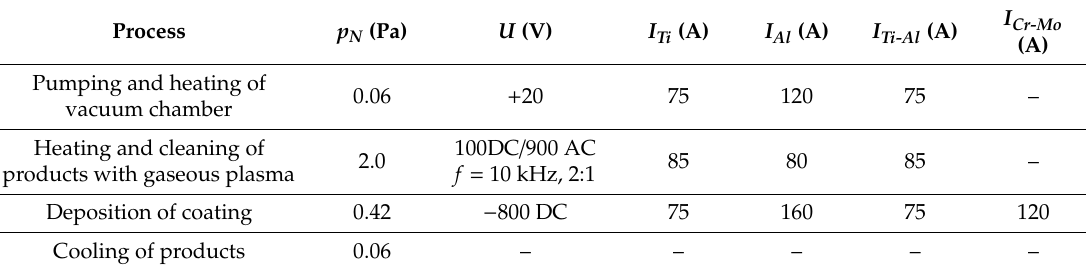
Table 1. Parameters of stages of the technological process of the deposition of